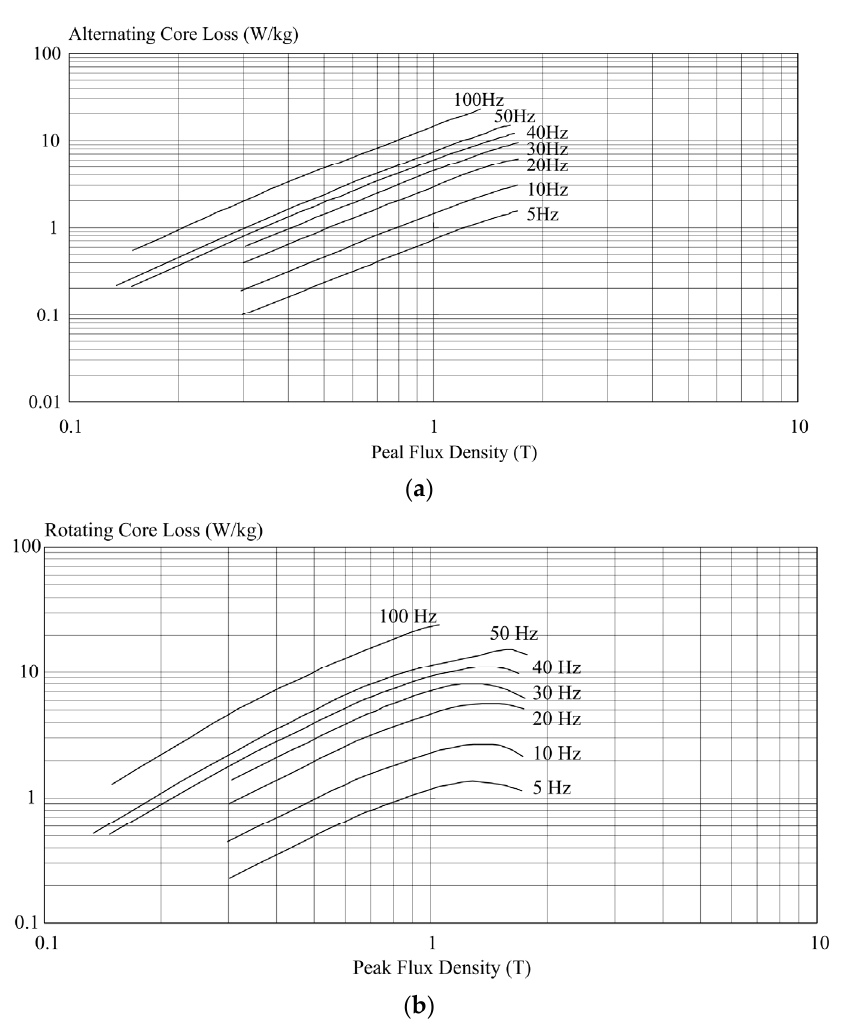
Figure 6. Measured core losses of a soft magnetic composite sample under ( a ) alternating and ( b ) circularly rotating magnetic flux densities of different frequencies.